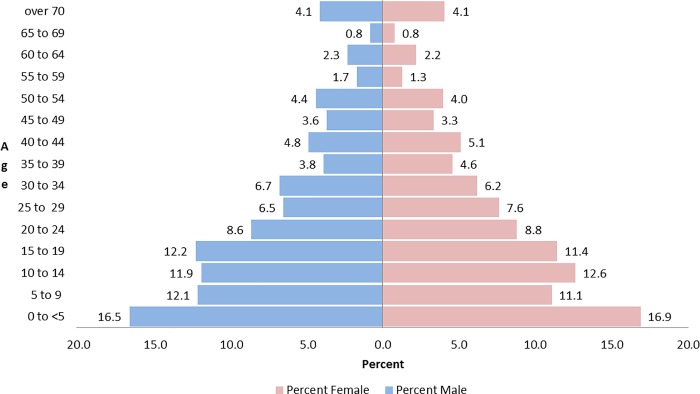
Lahe township population pyramid stratified by sex.